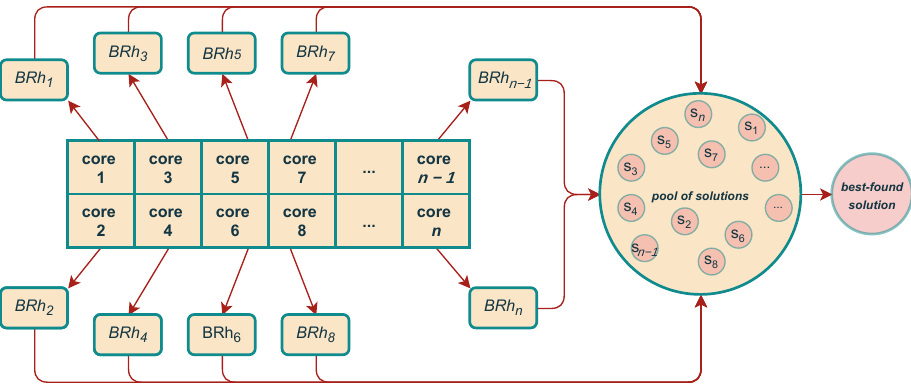
Figure 2. The concept of agile